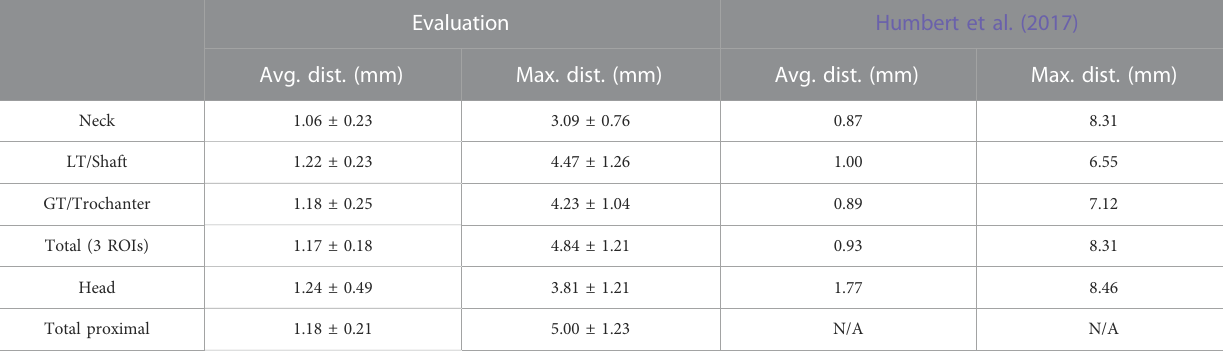
TABLE 2 Mean and standard deviation of the average and maximal surface distances. LT and GT stand for lesser and greater trochanter, respectively, and were named shaft and trochanter by Humbert et al. (2017).